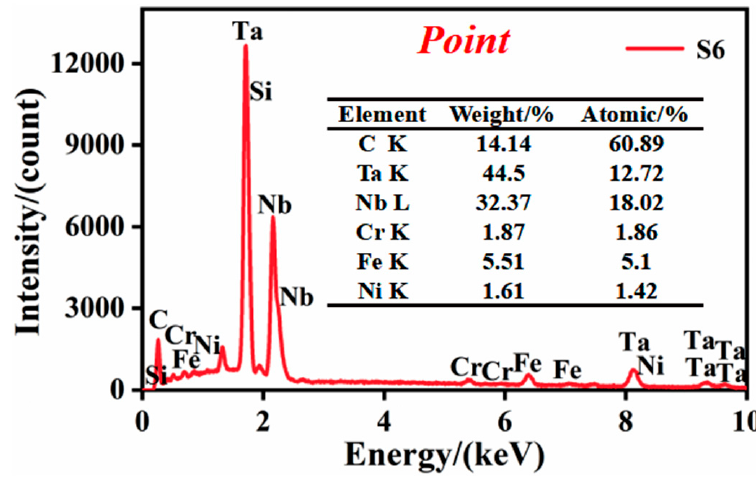
Figure 6. The point analysis of element concentration of the point in Figure 4.